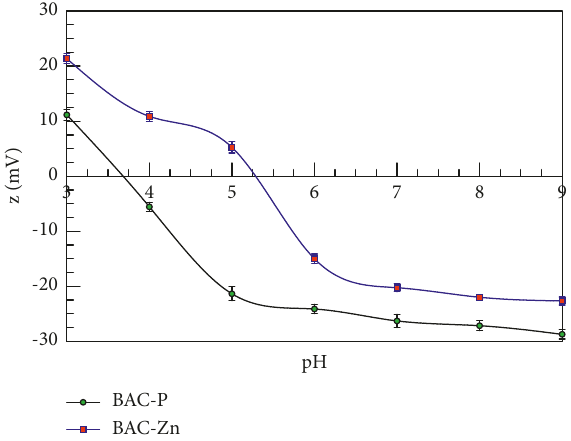
Figure 4: Zeta potential of BAC-P and BAC-Zn adsorbents. Error bar shown is the standard deviation of the